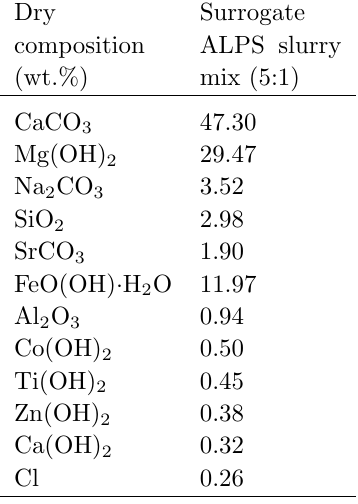
Table 1. Composition in wt.% of mixed ALPS slurries